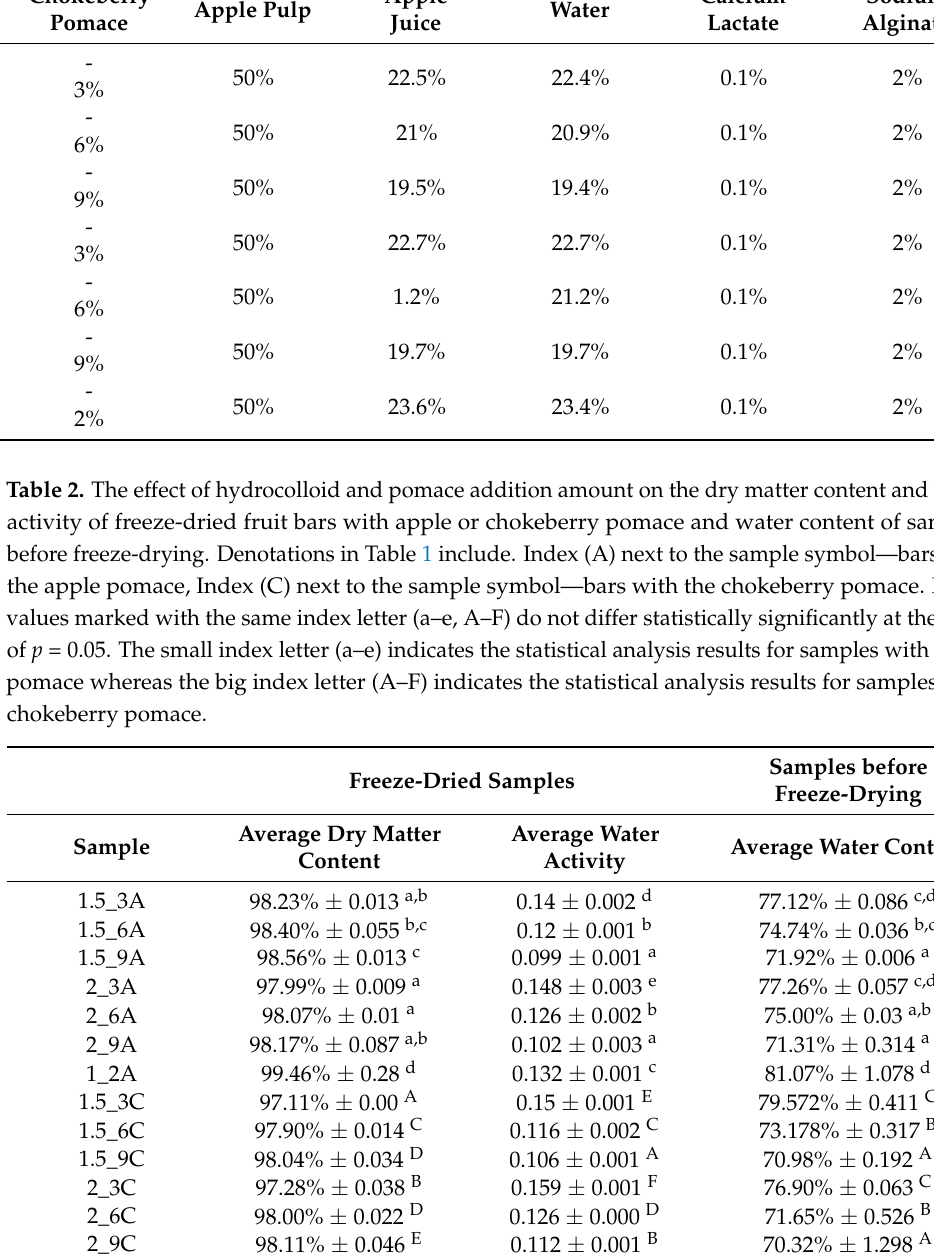
Table 1. Formulation of individual bar variants. Index (A) next to the sample symbol—bars with the apple pomace, Index (C) next to the sample symbol—bars with the chokeberry pomace.